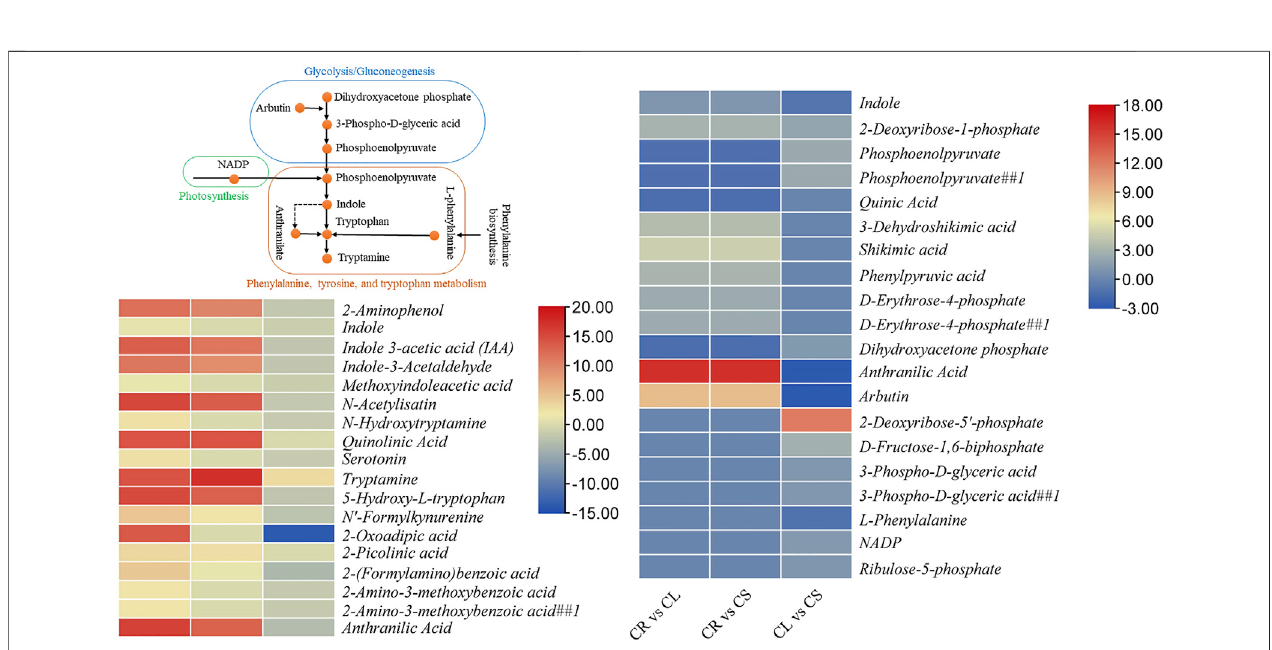
FIGURE4| Differential regulationoftryptophan metabolism pathway in C.convolvulacea leaf(CL), stem(CS),and tuber(CR).Theheatmapsshow themetabolites that were enriched in tryptophan metabolism and/or the upstream pathways.